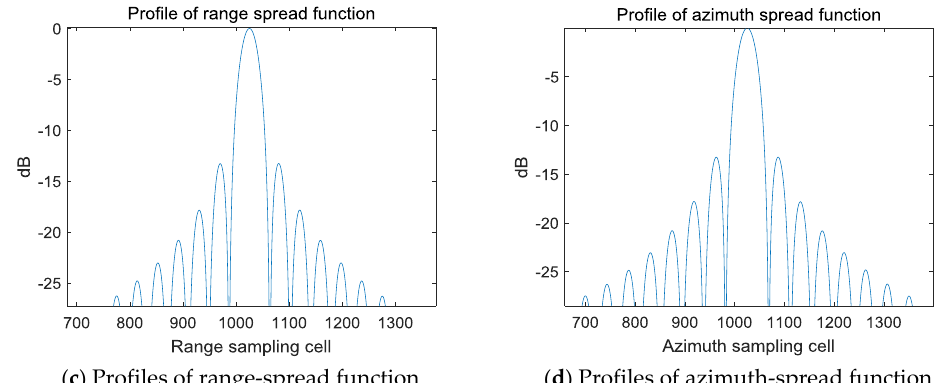
Figure 11. Imaging result of the forward-looking beam.